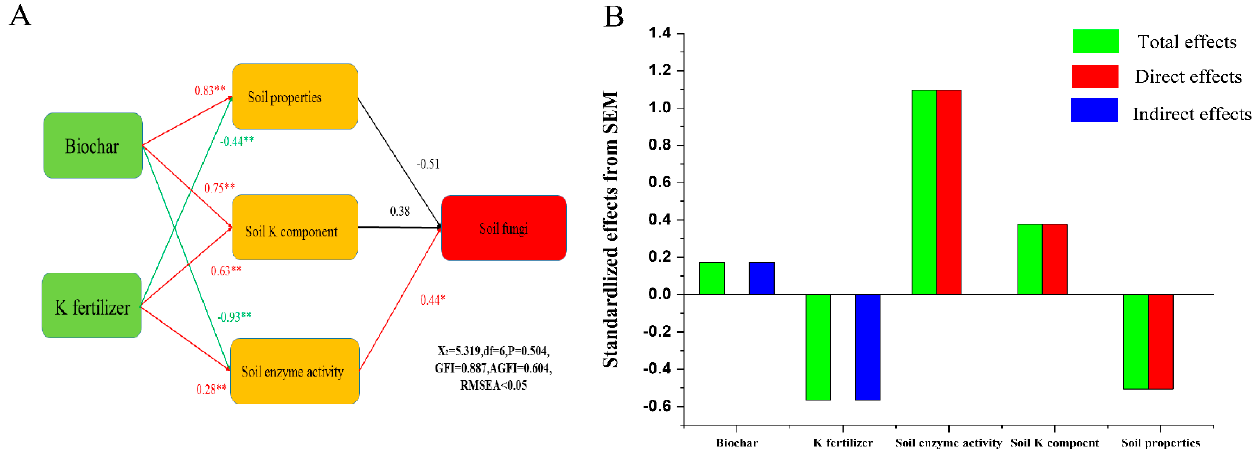
Figure 6. The structural equation modeling (SEM) shows the influences and effects of biochar and K fertilizer on soil properties, soil K components, soil enzyme activity, and soil fungi. The numbers above the arrows denote the standardized path coefficients. The red and yellow arrows indicate positive and negative effects, respectively ( A ). The standardized regression and influence effects of the structural equation modeling (SEM) ( B ). Stars denote significance at p < 0.05 and p < 0.01 proba ‐ bility levels (* and **, respectively).